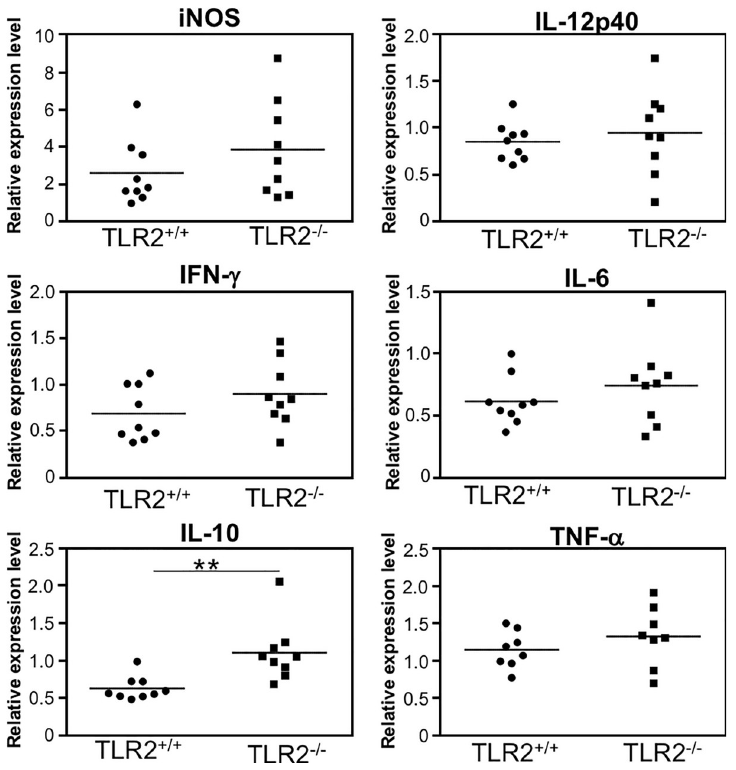
Fig 5. iNOS and cytokine mRNA expression in the brains of T . gondii -infected TLR2 +/+ and TLR2 –/– mice. TLR2 +/+ and TLR2 –/– mice were infected with T . gondii tachyzoites. On day 30 after infection, brain samples from all the mice were collected. Total RNA was extracted from each sample and iNOS and cytokine mRNA expression was quantified by real-time PCR. Each circle and square represent the data for one mouse, and the bars represent the average values of all the data points in two independent experiments (TLR2 +/+ mice, n = 9; TLR2 –/– mice, n = 9). Significant differences were determined by unpaired t tests ( � p <